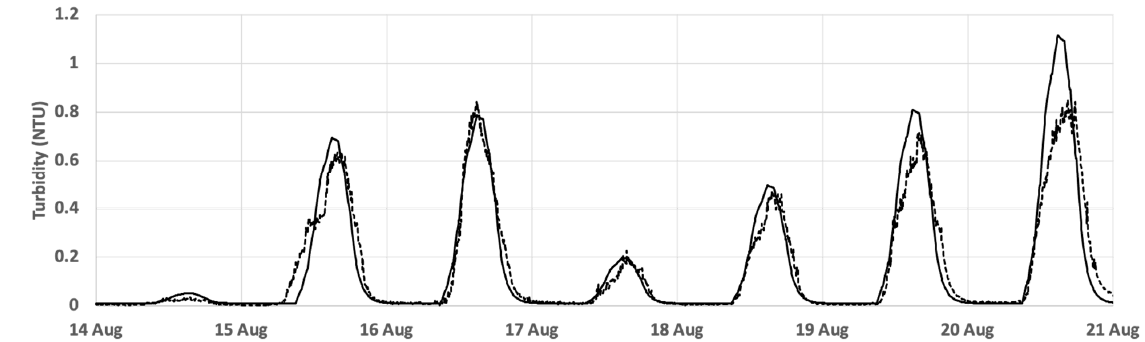
Figure 4. Comparison of the measured time course of turbidity (NTU) (dashed line) over 7 days with the prediction (solid line) made using Equations (12) and (14) and with values of K p = 0.35 NTU (bather m − 3 ) − 1 , T w = 1.06 h, and E = 0.9. The number of bathers entering the pool each hour was derived from the recorded daily bather numbers, and an assumed frequency distribution during the opening hours. Based on data of Stauder and Rodelsperger [13].